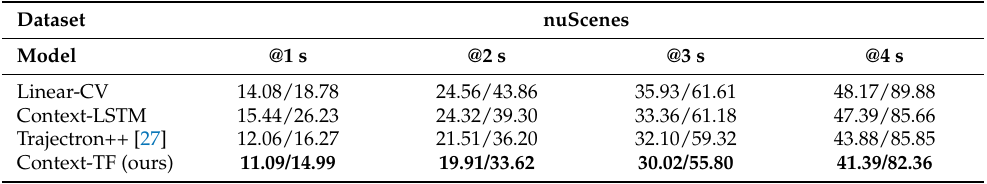
Table 4. The performance of our proposed Context-TF approach in comparison to baseline approaches on the validation split of the nuScenes dataset [31]. The reported scores are shown according to the evaluation metrics (ADE/FDE) in centimetres. Lower scores are